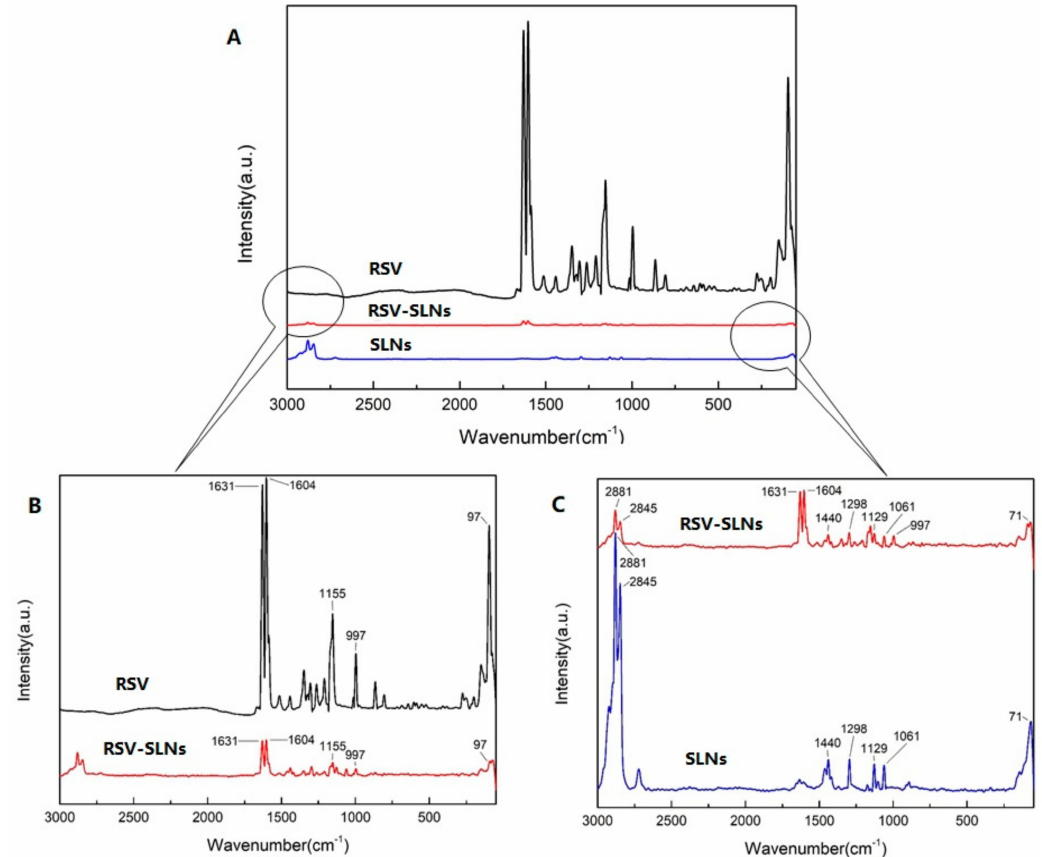
Figure 3. Raman spectra of RSV, RSV-SLNs and SLNs ( A ); the larger views of RSV, RSV-SLNs ( B ) and RSV-SLNs, SLNs ( C